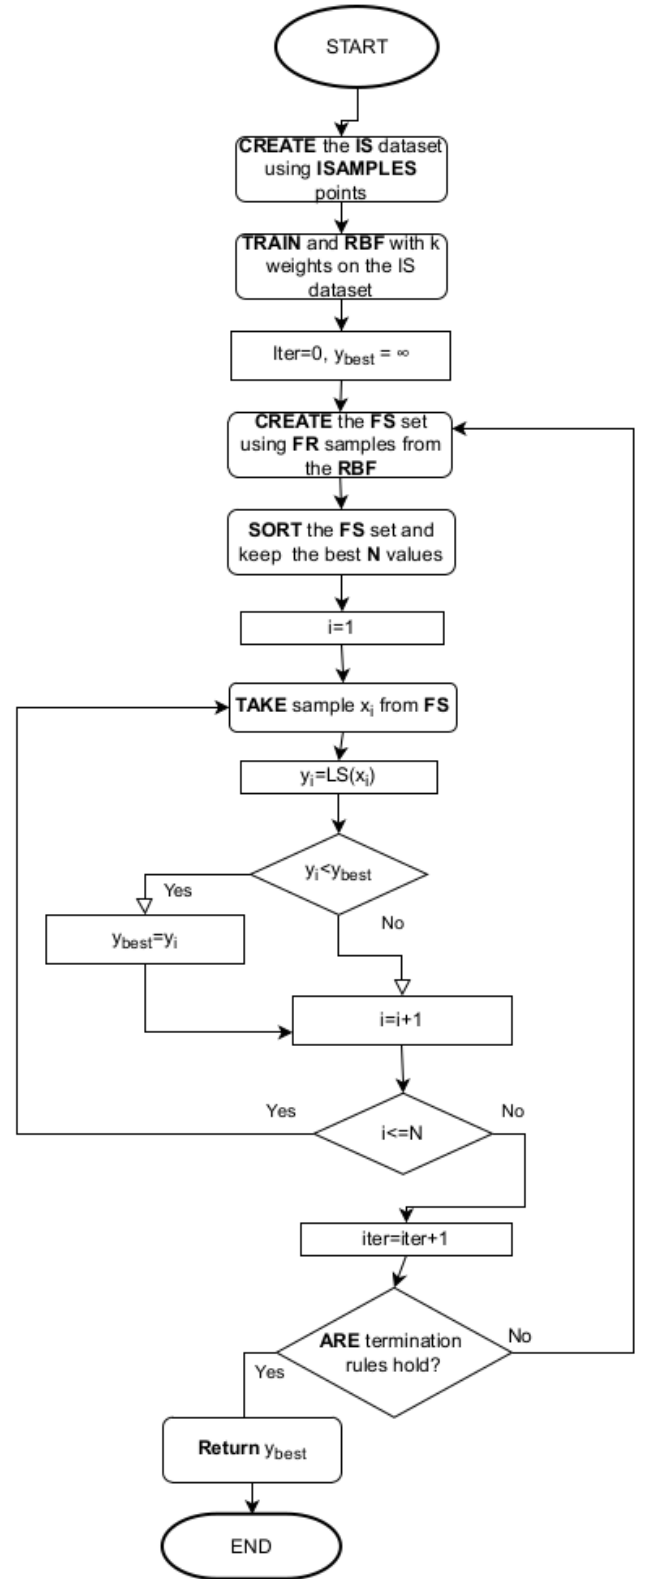
Figure 5. The Overall Algorithm as a